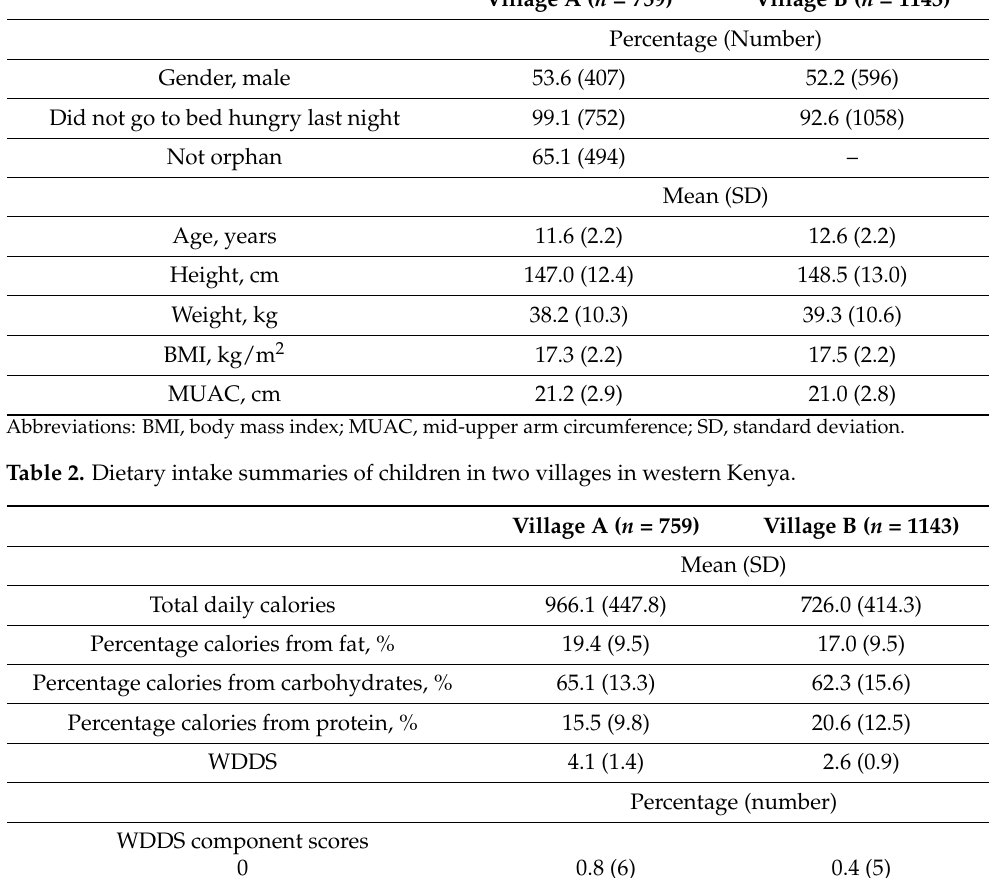
Table 1. Sociodemographic and anthropometric characteristics of children in two villages in western Kenya. Village A ( n = 759) Village B ( n = 1143)